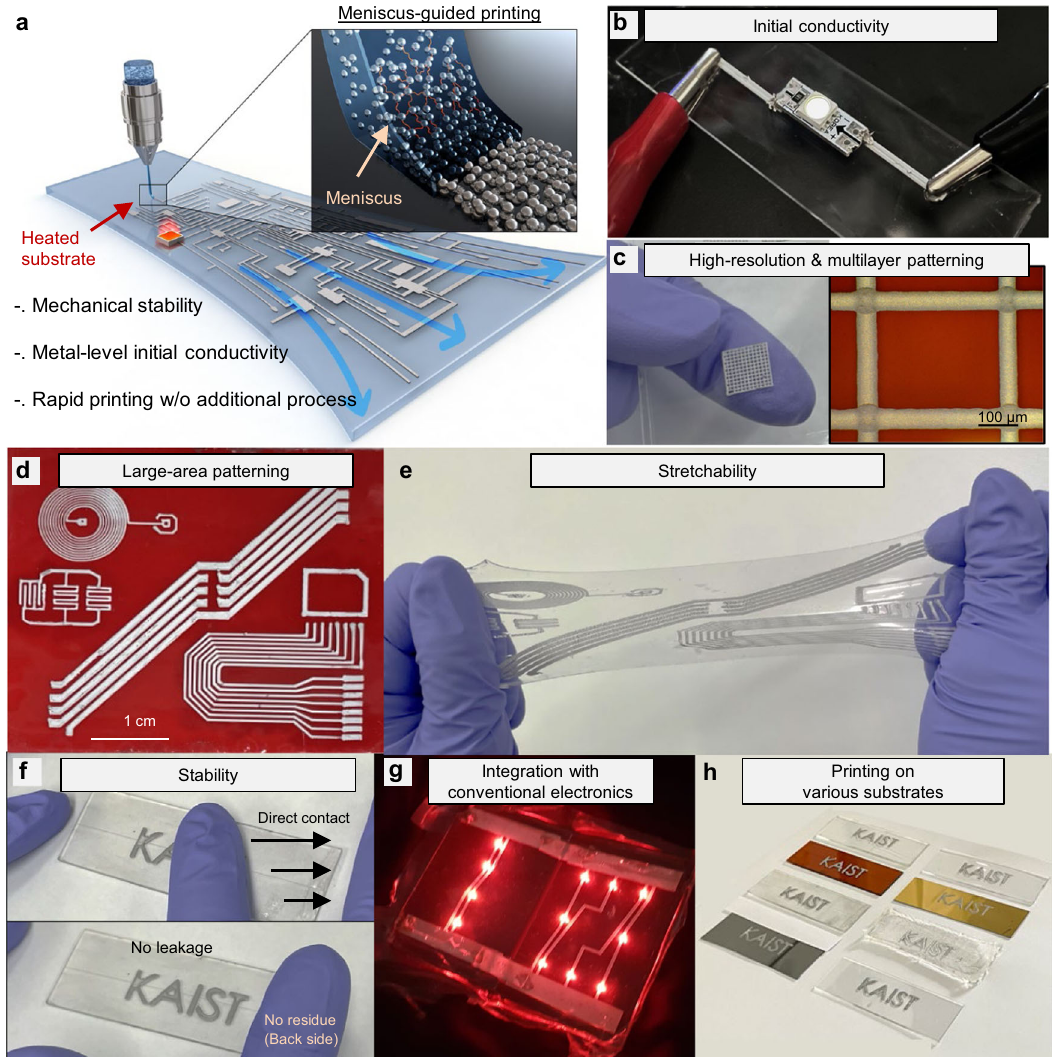
Fig. 1 Meniscus-guided printing (MGP) process of polyelectrolyte-attached liquid metal microgranular-particles (PaLMP) and demonstrated characteristics. a Schematic illustration of MGP process of PaLMP. b – h , Photograph of demonstrated characteristics: initial electrical conductivity ( b ), high-resolution/multi-layer patterning ( c ), large-area patterning ( d ), stretchability ( e ), mechanical stability ( f ), integration capability with conventional electronics ( g ), printing capability on various substrates ( h